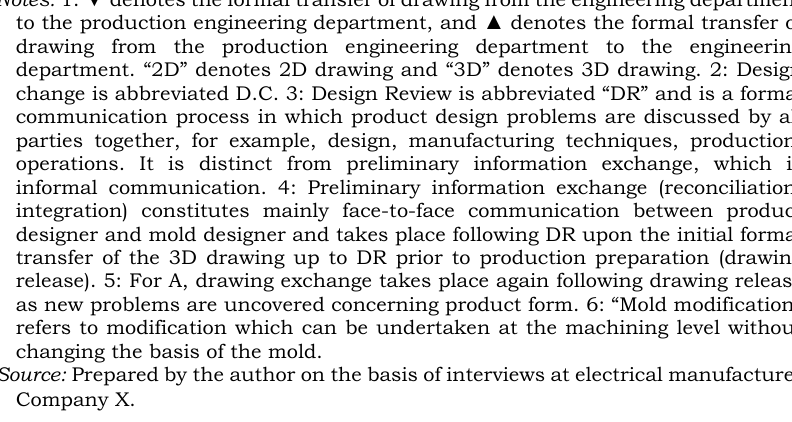
Figure 2. Development process of Product A and Product